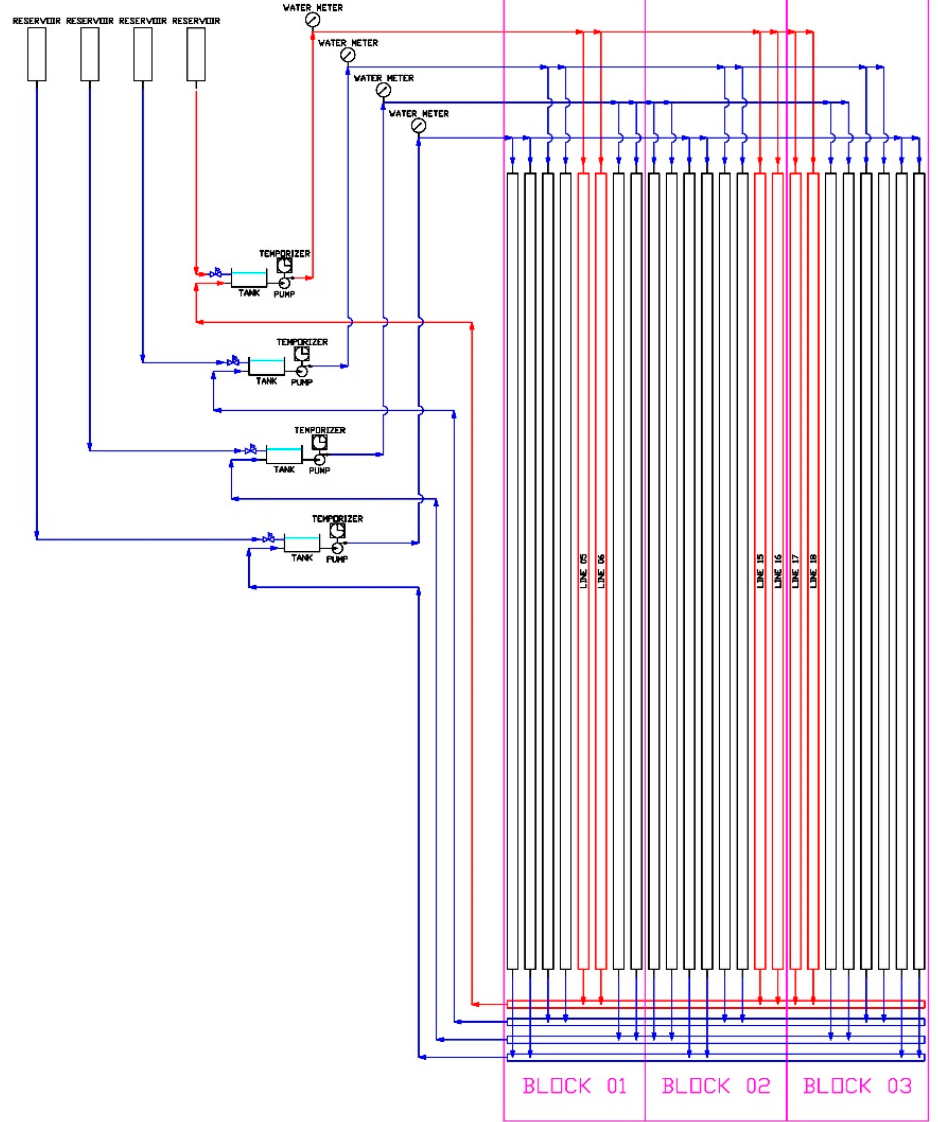
Figure 4. Scheme of the lab-scale pilot plant (LSPP). The blue circuit refers to the HNS flow. The red path represents a single treatment; the specific path was chosen randomly for representation purposes. The blue rectangles are the gutters. The black rectangles are the NGS ® lines.